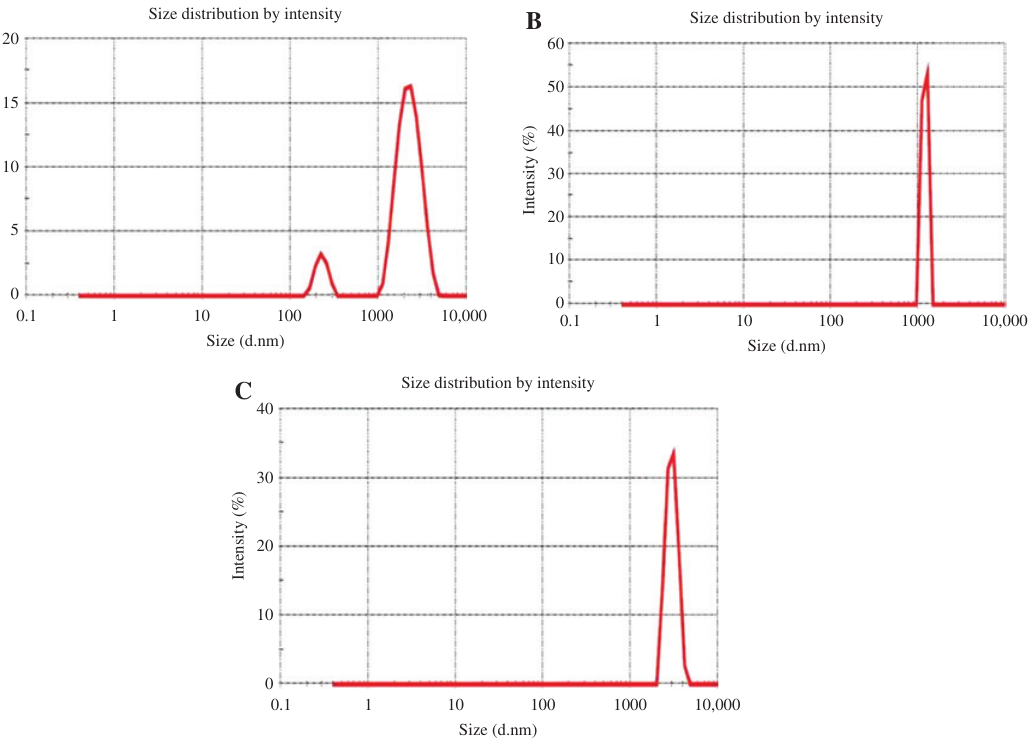
composites fabricated at 30 min AT and HTs of (A) 20 min, (B) 30 min, and 2